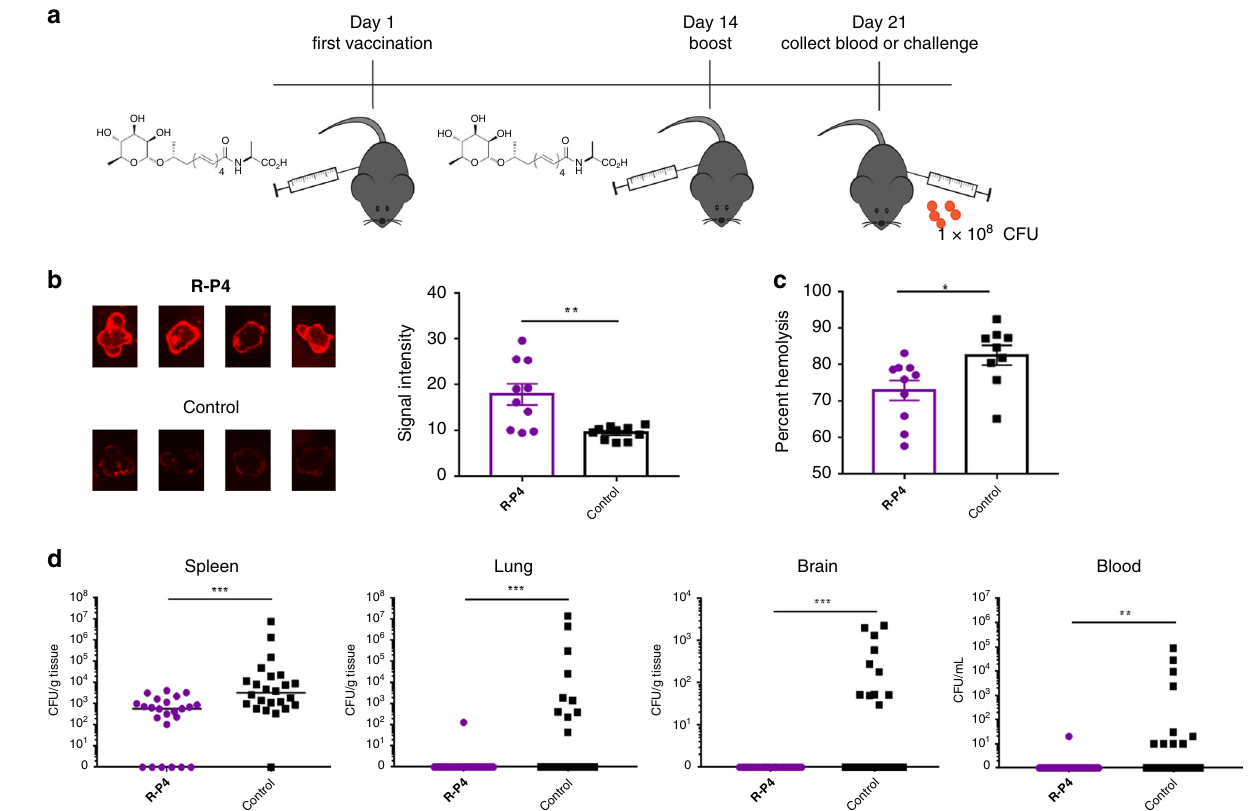
Fig. 5 Vaccination with a non-toxic synthetic analog diminished GBS infection. a Mice were vaccinated with an emulsion of R-P4 (10 μ M in PBS) in complete Freund ’ s Adjuvant and boosted 14 days after initial vaccination using R-P4 in incomplete Freund ’ s Adjuvant. At 21 days, vaccinated mice were euthanized for blood/plasma collection or were challenged (IP) with ∼ 1 × 10 8 CFU of hyper-hemolytic GBS strain NCTC10/84. As controls, mice receiving adjuvant only were tested in parallel with the same schedule. b Approximately 4 μ L solvent or puri fi ed granadaene (25 μ M) was spotted on PVDF membranes, which were then blocked and probed with plasma from analog-vaccinated or adjuvant-only mice ( n = 10/group). Subsequently, the membranes were probed with secondary goat anti-mouse IgG (Alexa Fluor 680) and analyzed on the Odyssey LI-COR Imaging System. Four representative spots from each group are shown. Signal intensity of each spot was determined using the Image J software, and a two-tailed unpaired t test was used to compare signal intensity between groups ( p = 0.0020). Mean and standard error are shown. c Plasma (diluted 1:1000) from analog- vaccinated mice or adjuvant-only only mice ( n = 10/group) was pre-incubated with puri fi ed granadaene (0.3 μ M) for 1 h and then incubated with human red blood cells for 1 h. Percent inhibition of granadaene hemolysis was calculated (see Methods), and a two-tailed unpaired t test was used to compare hemolysis inhibition by R-P4 plasma vs. control plasma ( p = 0.0004). Mean and standard error are shown. d GBS CFU recovered from the blood, spleen, lung, and brain of mice ( n = 24) at 24 h post infection were compared using a two-tailed Mann – Whitney test. Blood: p = 0.0025, spleen: p = 0.0001, lung: p = 0.0010, brain: p = 0.0002. *, p < 0.05. **, p < 0.01. ***, p <